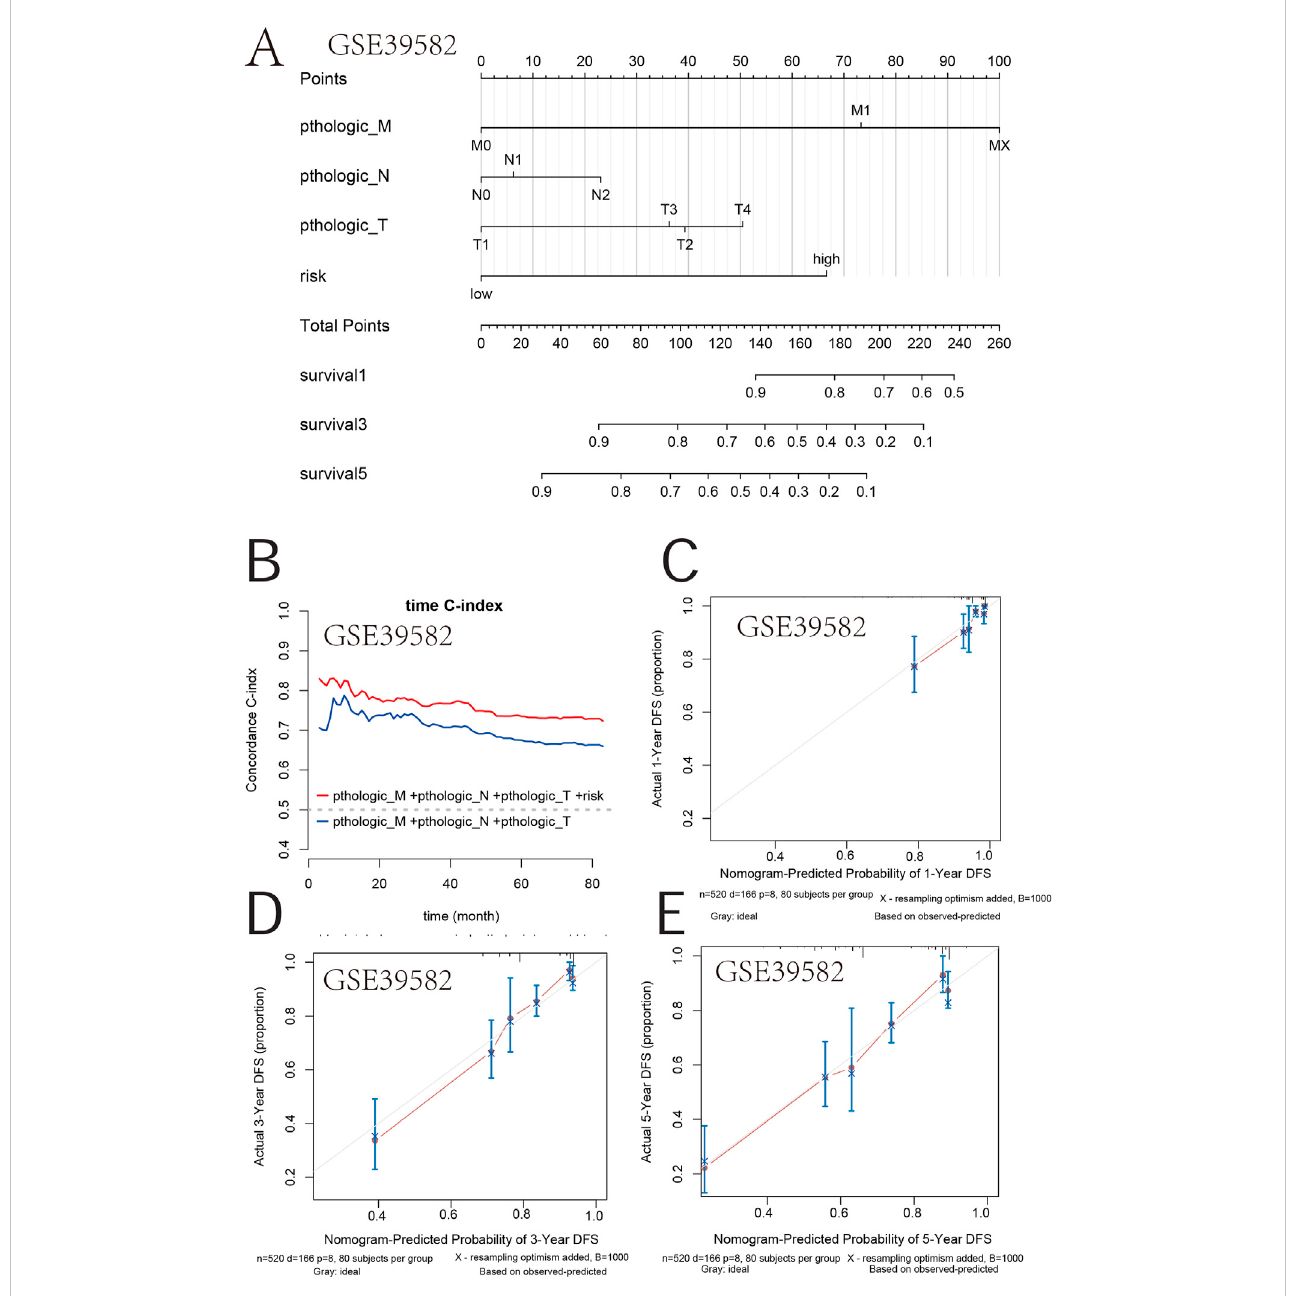
FIGURE 8 Survival nomogram. (A) Nomogram for the overall survival was developed in the primary cohort with three prognostic factors: pthologic M, pthologic N, and pthologic T. (B) Compared with the TNM and TNM + risk, the novel nomogram exhibited a better powerful capacity for survival prediction. (C – E) Nomogram predicting the 1-, 3-, and 5-year overall survival of COAD patients in